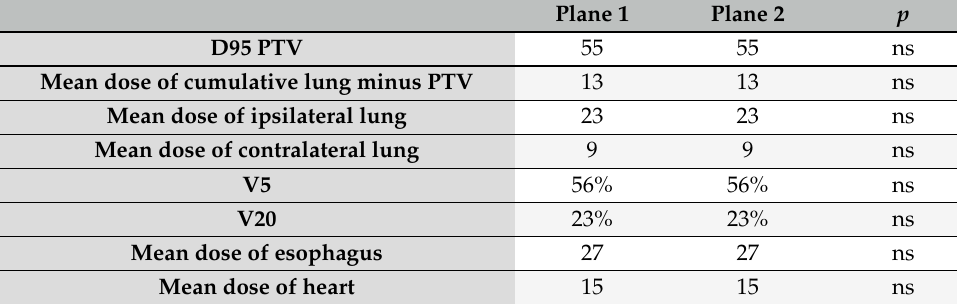
Table 2. Results of the DVH of plane 1 and plane